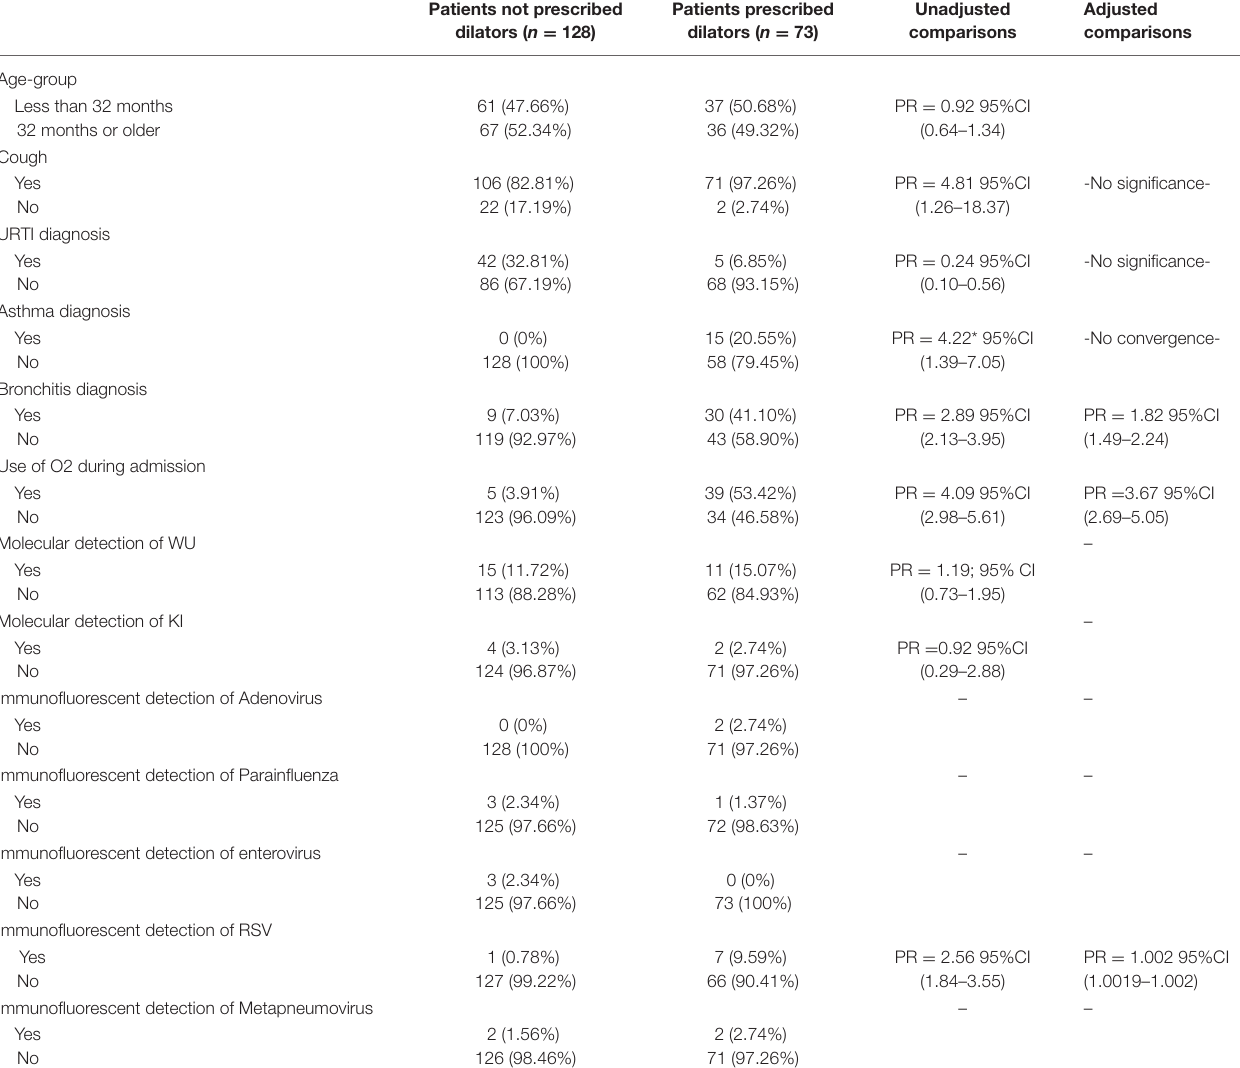
TABLE 6 | Characteristics of 201 pediatric study subjects and an examination of their risk factors for the use of bronchodilators during admission, Singapore December 2016 to April 2017.